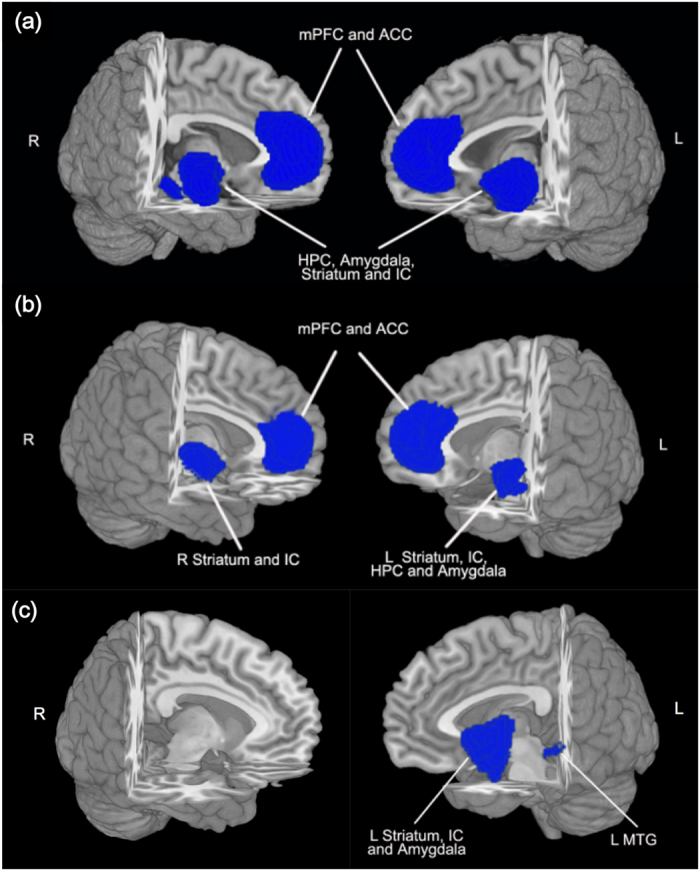
The brain regions exhibiting GM reduction in PTSD compared with TEC in the pooled meta-analysis (a), and subgroup analyses by single-incident (b) and prolonged trauma (c). The regions are displayed in a 3D brain, with part of the left or right hemisphere removed. Blue areas depict significant GMRs by AES-SDM in PTSD compared with TEC. Abbreviations: mPFC, medial prefrontal cortex; ACC, anterior cingulate cortex; HPC, hippocampus; IC, insula cortex; MTG, middle temporal gyrus; L, left; R, right.